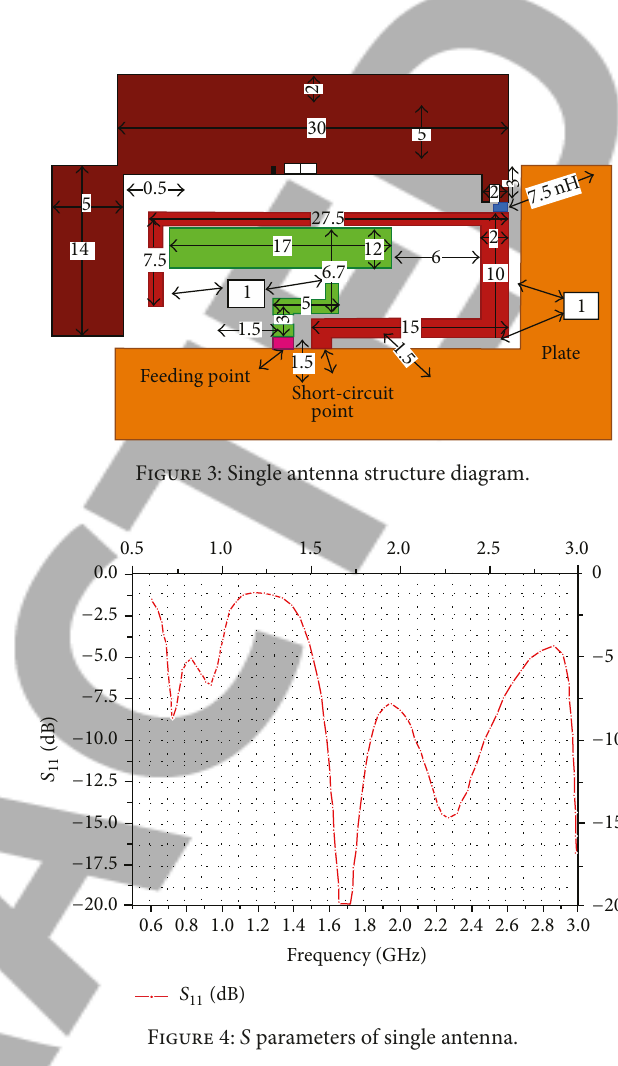
Figure 4: 𝑆 parameters of single